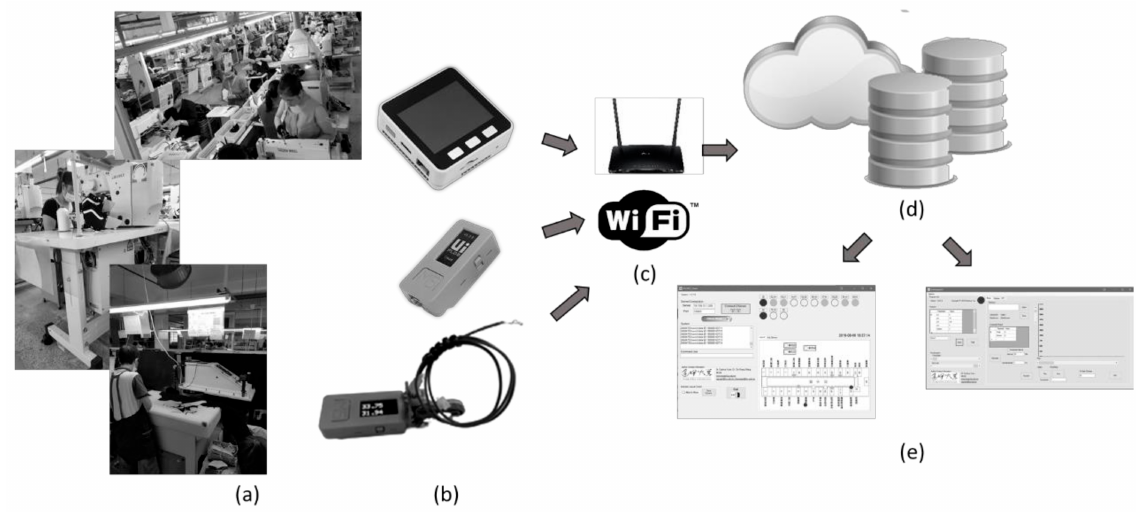
Figure 1. The IoT architecture, including ( a ) the field; ( b ) sensors with the preliminary information processing capability; ( c ) secured wireless hub; ( d ) cloud-base database and ( e ) the end